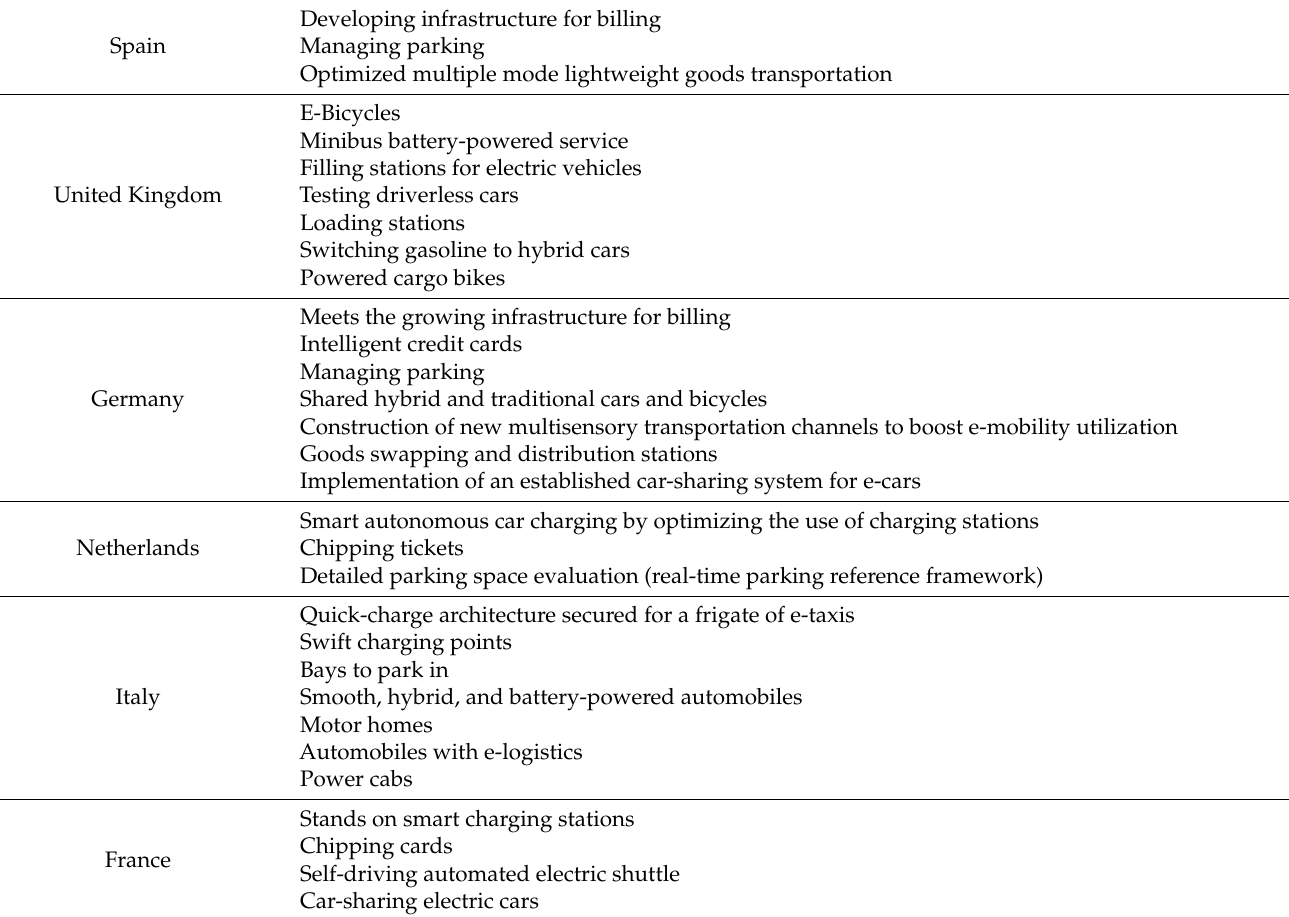
Table 4. Potential mobility indicators